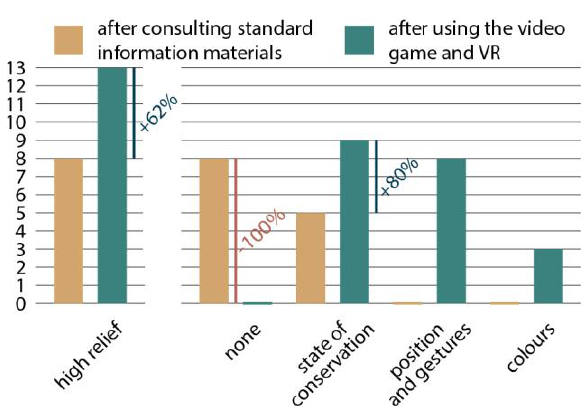
Figure 8. Chronological analysis of participants’ interaction